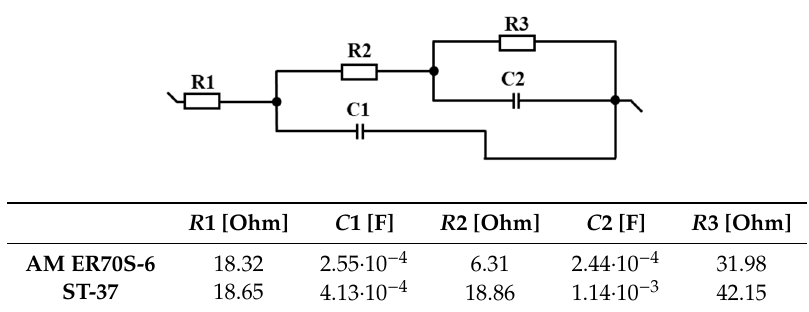
Figure 6. Electrical equivalent circuit and related fitted parameters for Nyquist and Bode diagrams plots shown in Figure 5.